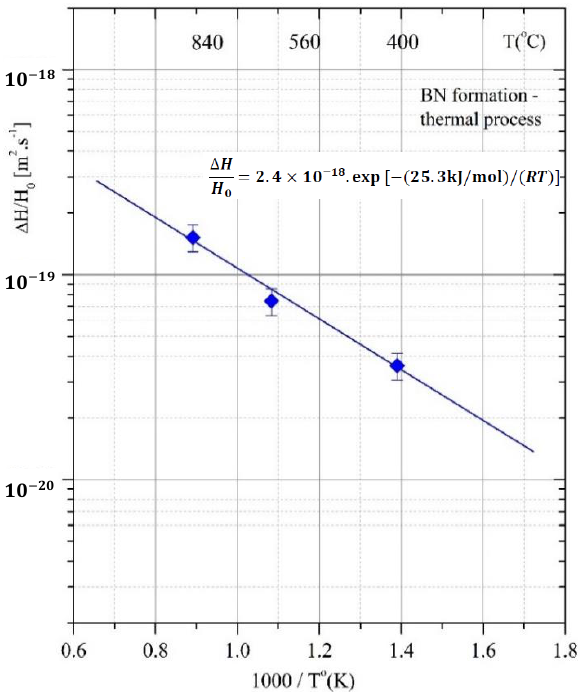
Figure 13. Arrhenius plot of BN phase formation for the annealed samples (1 h) in N 2 -atmosphere.